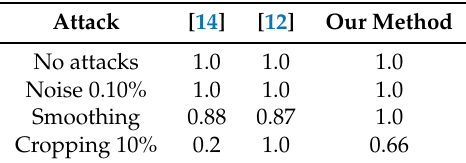
Table 16. Robustness comparison with Cho’s [14], and Medimegh’s [12] schemes measured in terms of